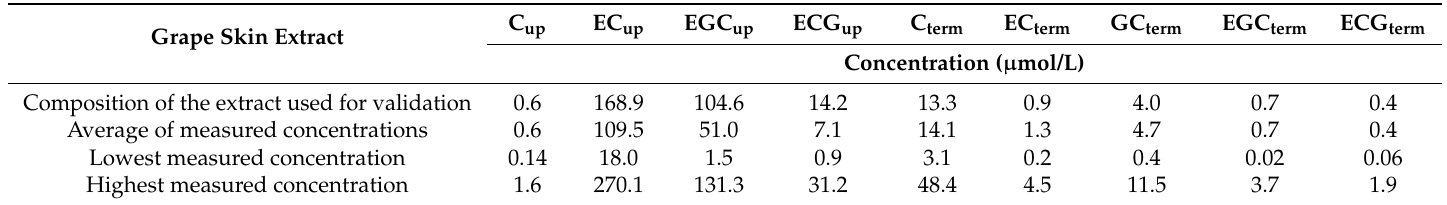
Table 2. Composition of the grape skin extract used for validation compared to the range of concentrations and average concentrations measured in a panel of 50 red and white grape skin extracts.